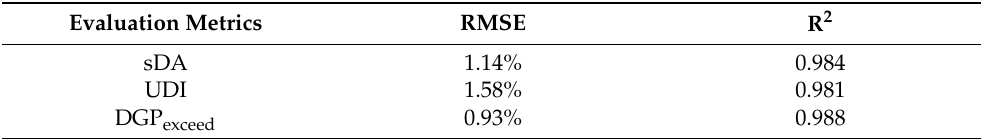
Table 4. Prediction accuracy of GBRT